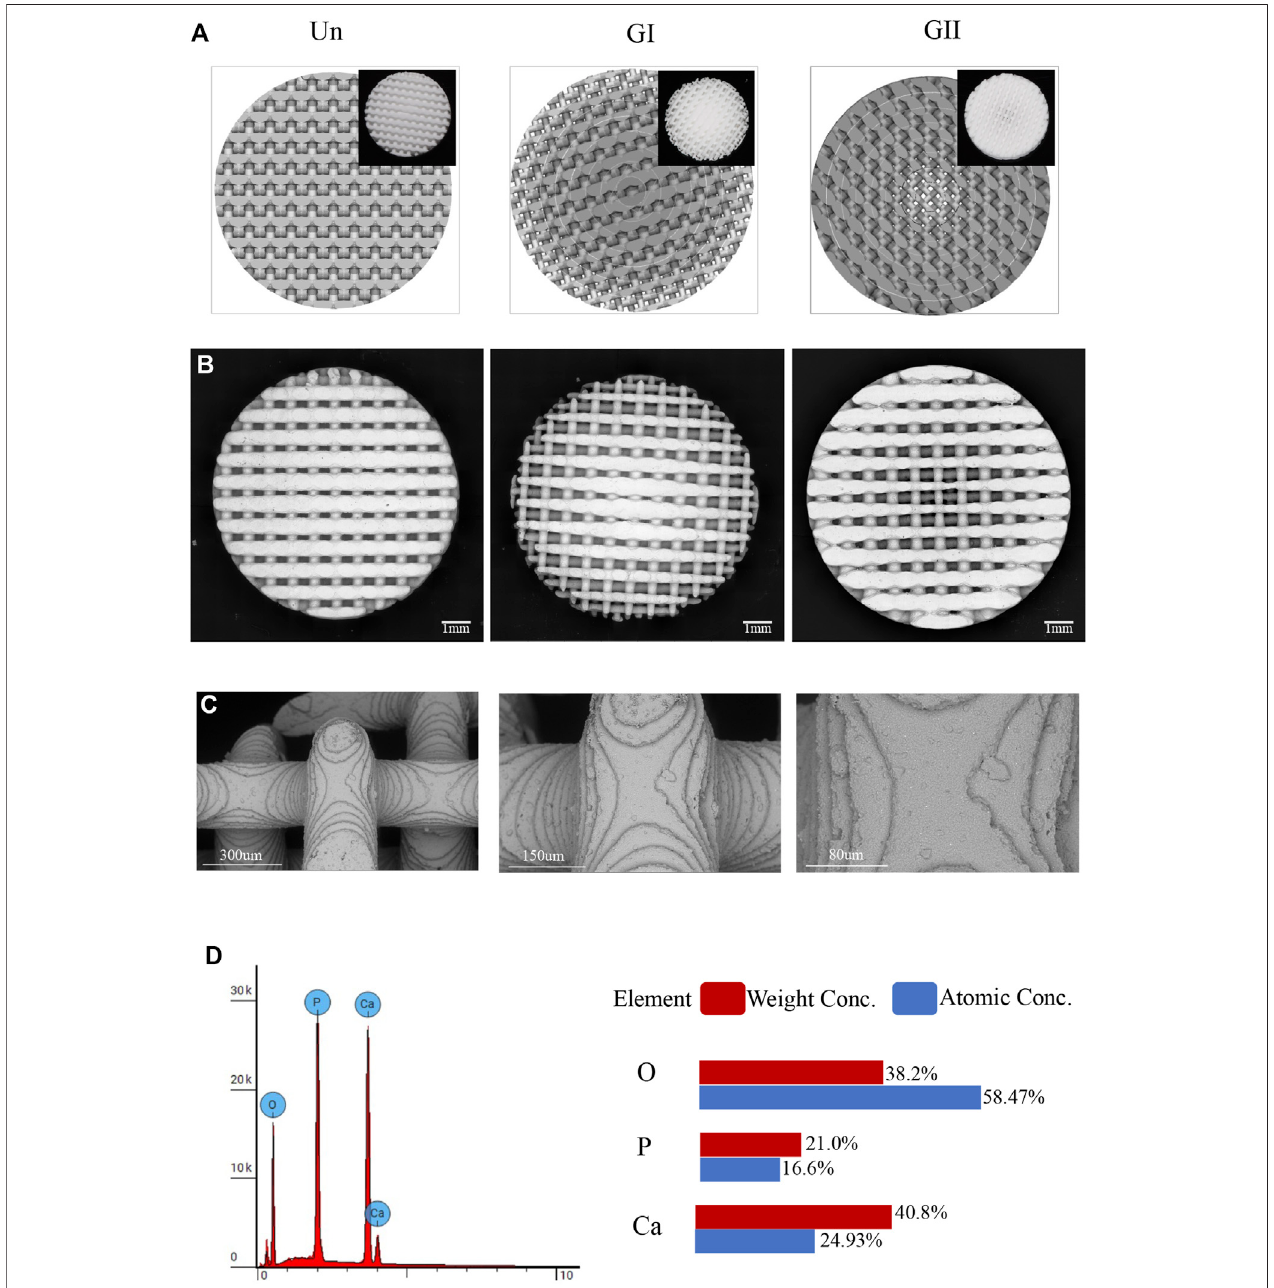
FIGURE1| Physicaland chemical properties ofthescaffold. (A) The design ofscaffolds structures and the printed images (top right). (B) Anelectro mirror diagram of scaffolds with different structures. (C) The images under electroscope of the scaffold are 500×, 1,000×, 2,000×. (D) EDS detection of the scaffold.